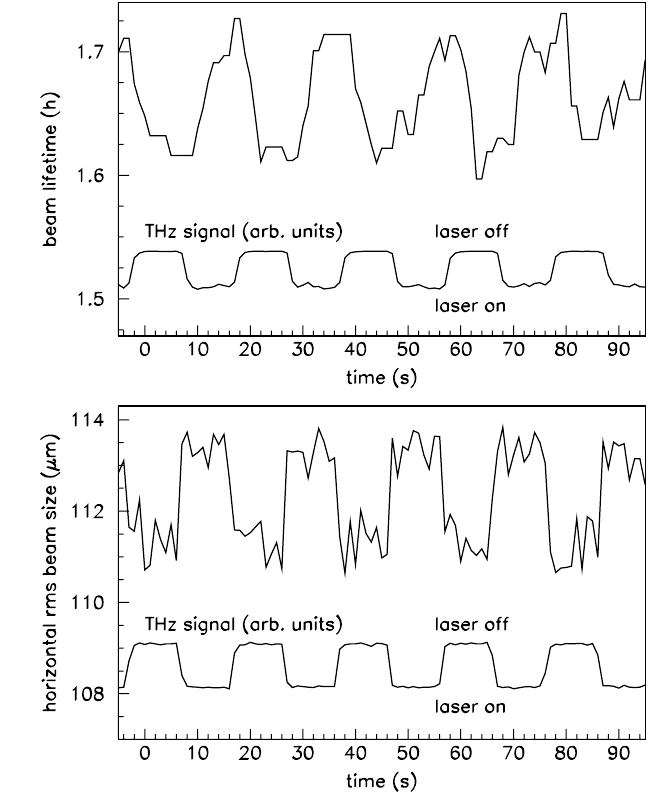
FIG. 7. Single-bunch lifetime (top) and horizontal rms beam size (bottom) as function of time, while the laser is blocked periodically as indicated by the THz